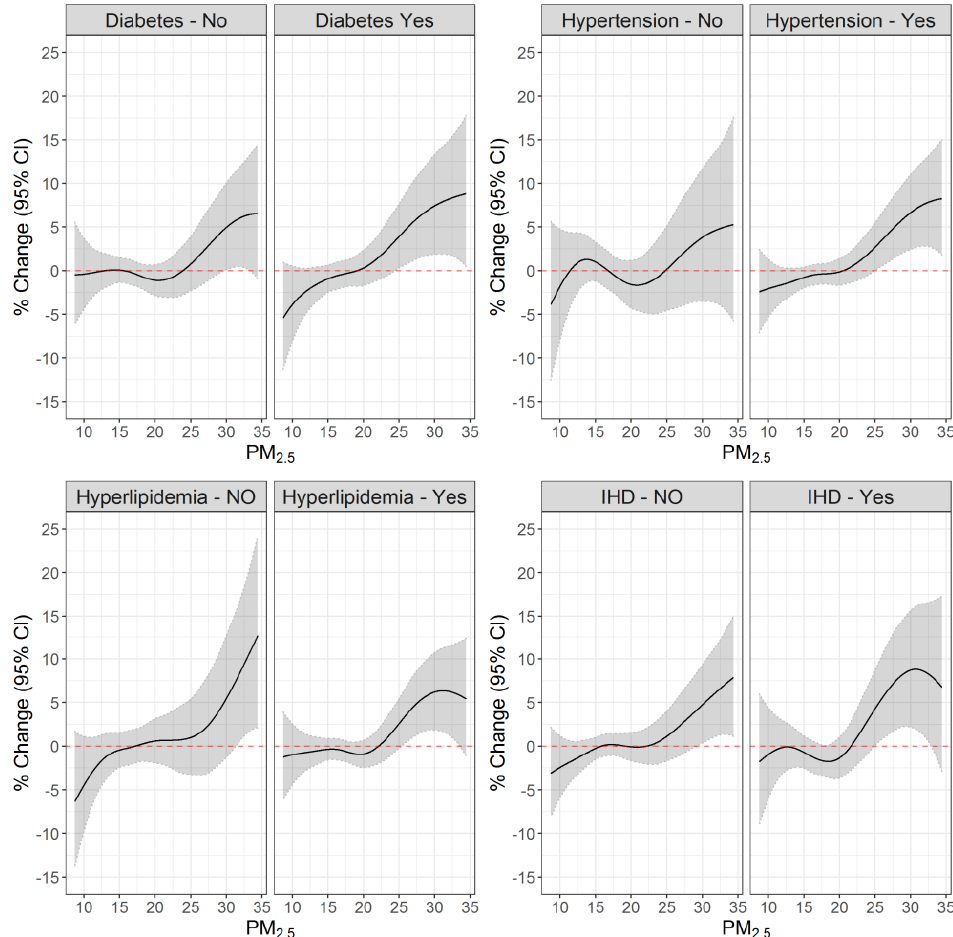
Figure 3. The association between PM 2.5 exposure on the event day and ischemic stroke/TIA stratified by cardiometabolic chronic conditions. Figure 3 shows the associations between PM 2.5 exposure on the event day and ischemic stroke/transient ischemic attack (TIA), stratified by diabetes, hypertension, hyperlipidemia, and ischemic heart disease (IHD).